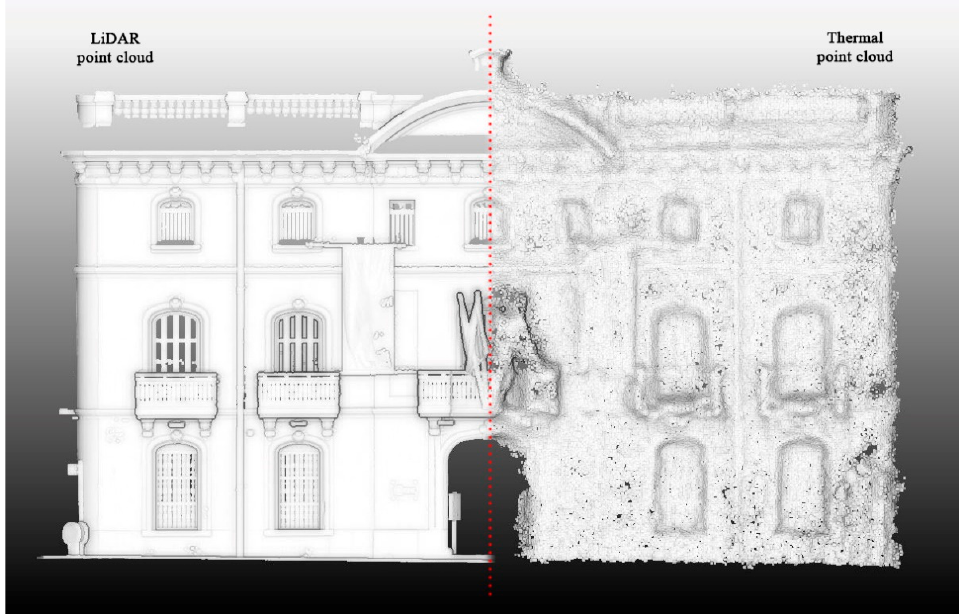
Figure 12. On the left, LiDAR point cloud of the southern façade. On the right, photogrammetric dense point cloud derived from TIR images.